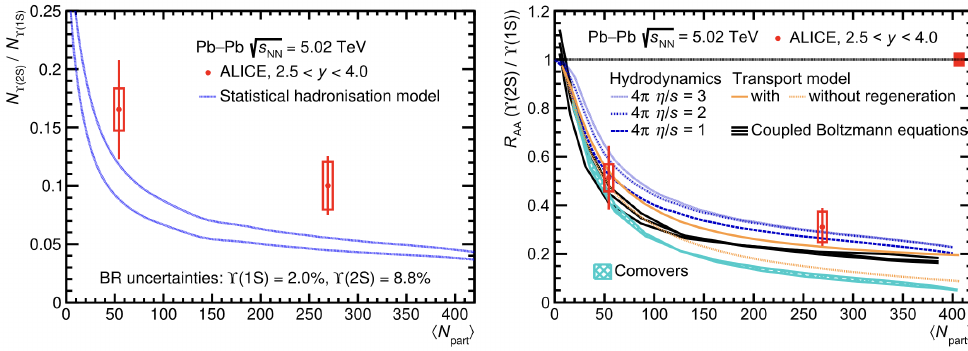
Figure 13. The Υ (2S) to Υ (1S) ratio of yields ( left ) and R AA ( right ) as a function of (cid:104) N part (cid:105) at forward rapidity in Pb + Pb collisions [70]. The data are compared with different theoretical models described in the text. Reprinted with permission from